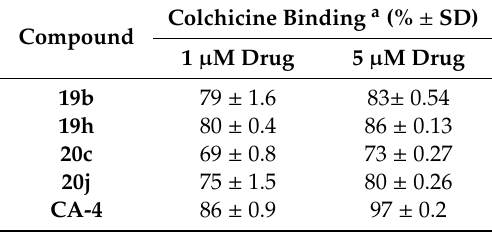
Table 2. Inhibition of [ 3 H] colchicine binding by selective quinoline compounds and